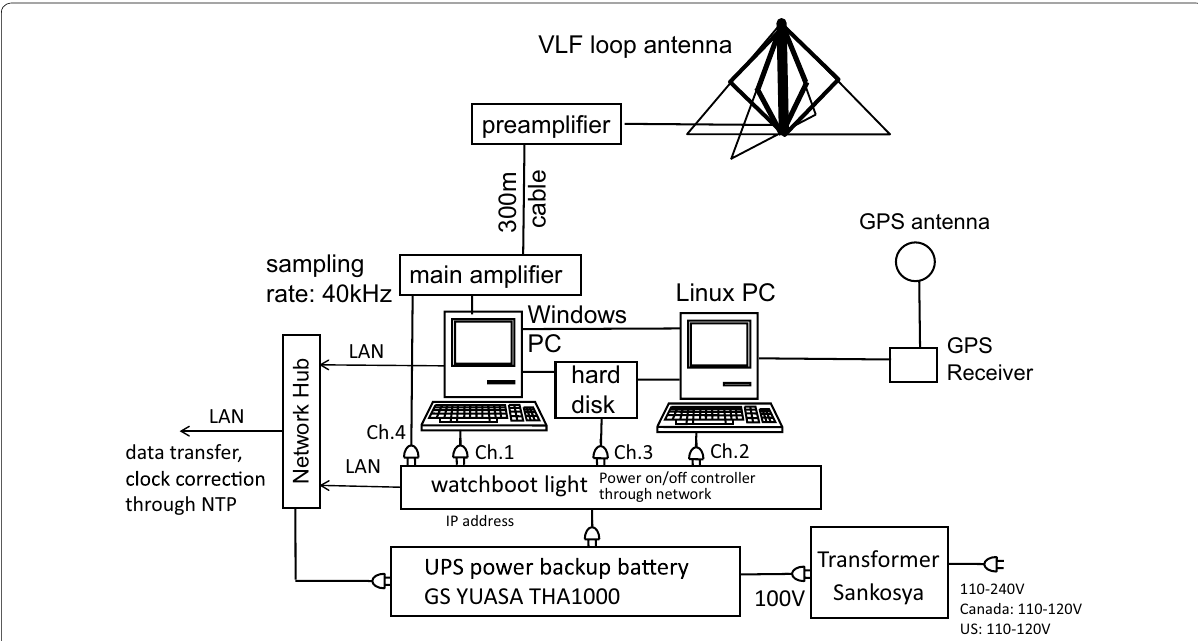
Fig. 11 Block diagram of the loop antenna system for ELF/VLF wave